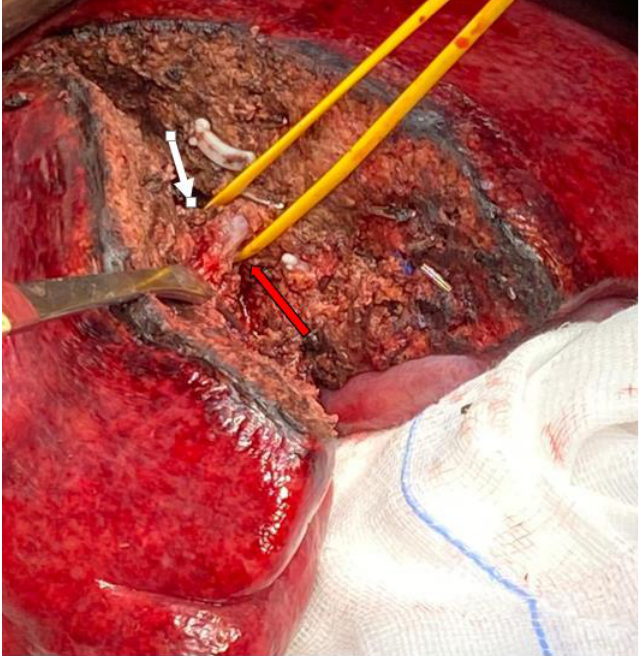
Figure 2. Anatomical segmentectomy of VI in colorectal liver metastasis (white arrow). Portal vein branch of VI-VII (red arrow).